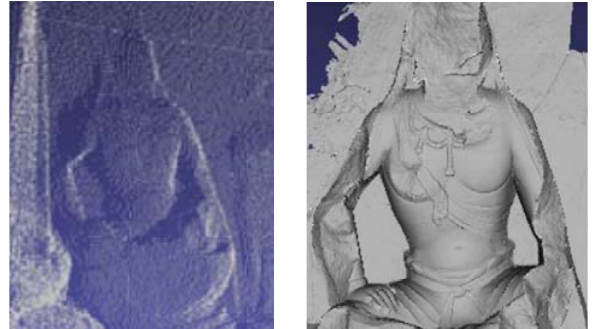
Fig.13 The 3D point cloud and surface model